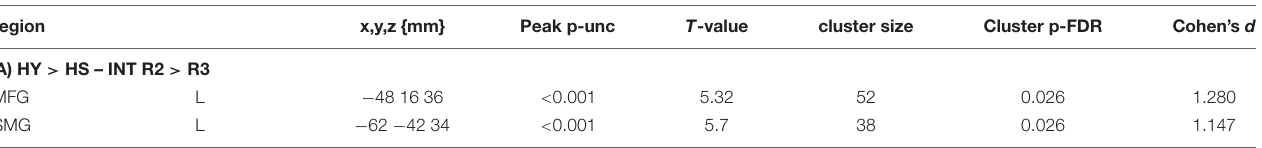
TABLE 6 | Interaction analyses with factors session and group for INT RS activity.